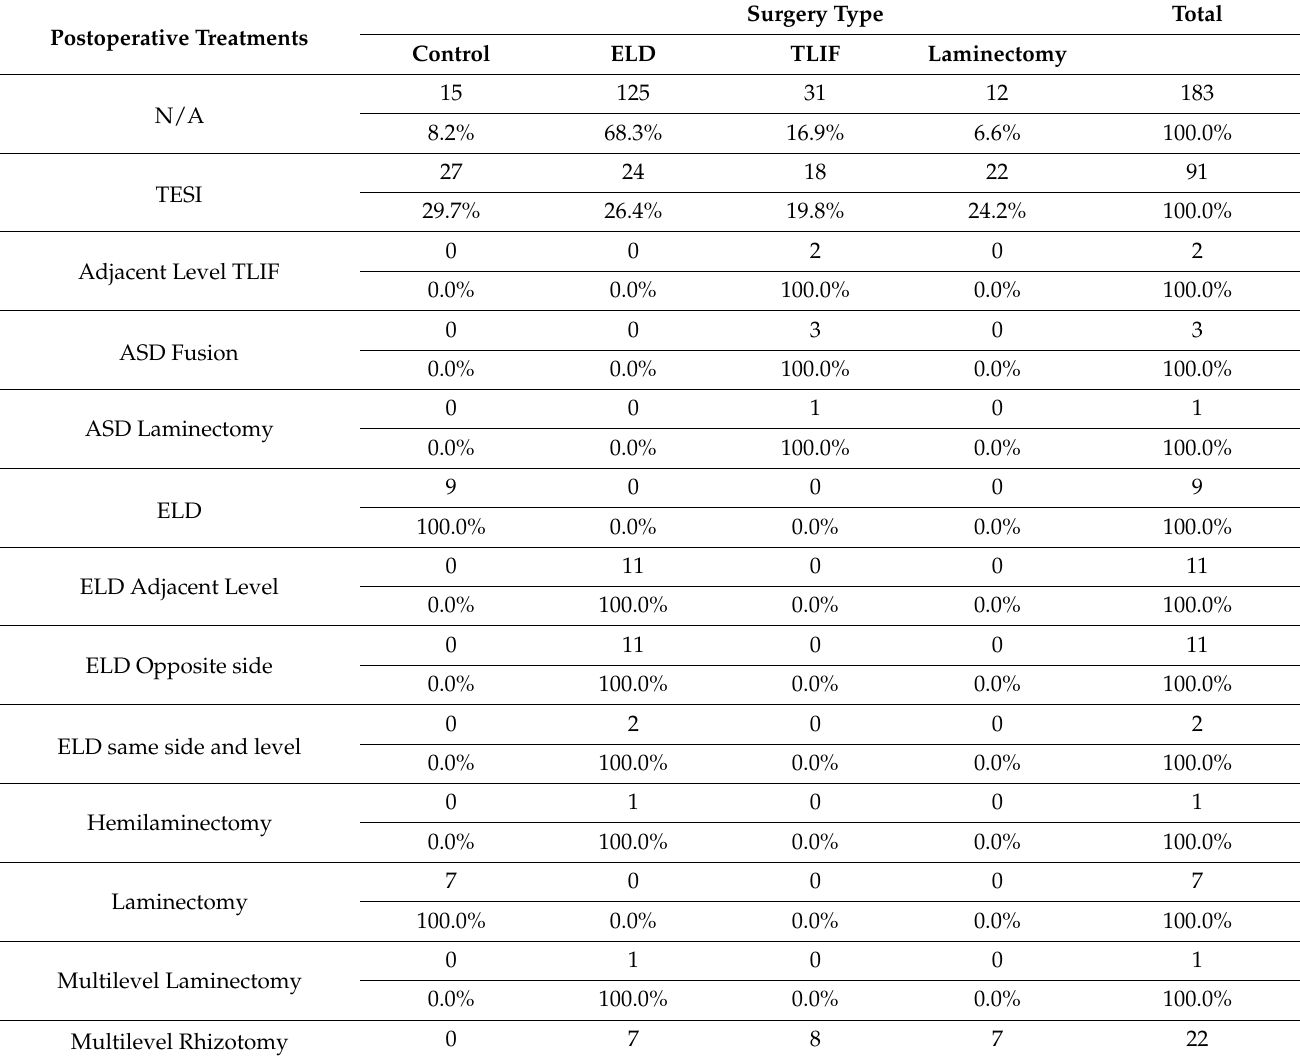
Table 5. Additional treatments for persistent or new-onset symptoms in control group patients and ELD patients following the targeted lumbar endoscopic decompression of visualized painful pathology based on SpineScreen, versus MRI-based laminectomy and